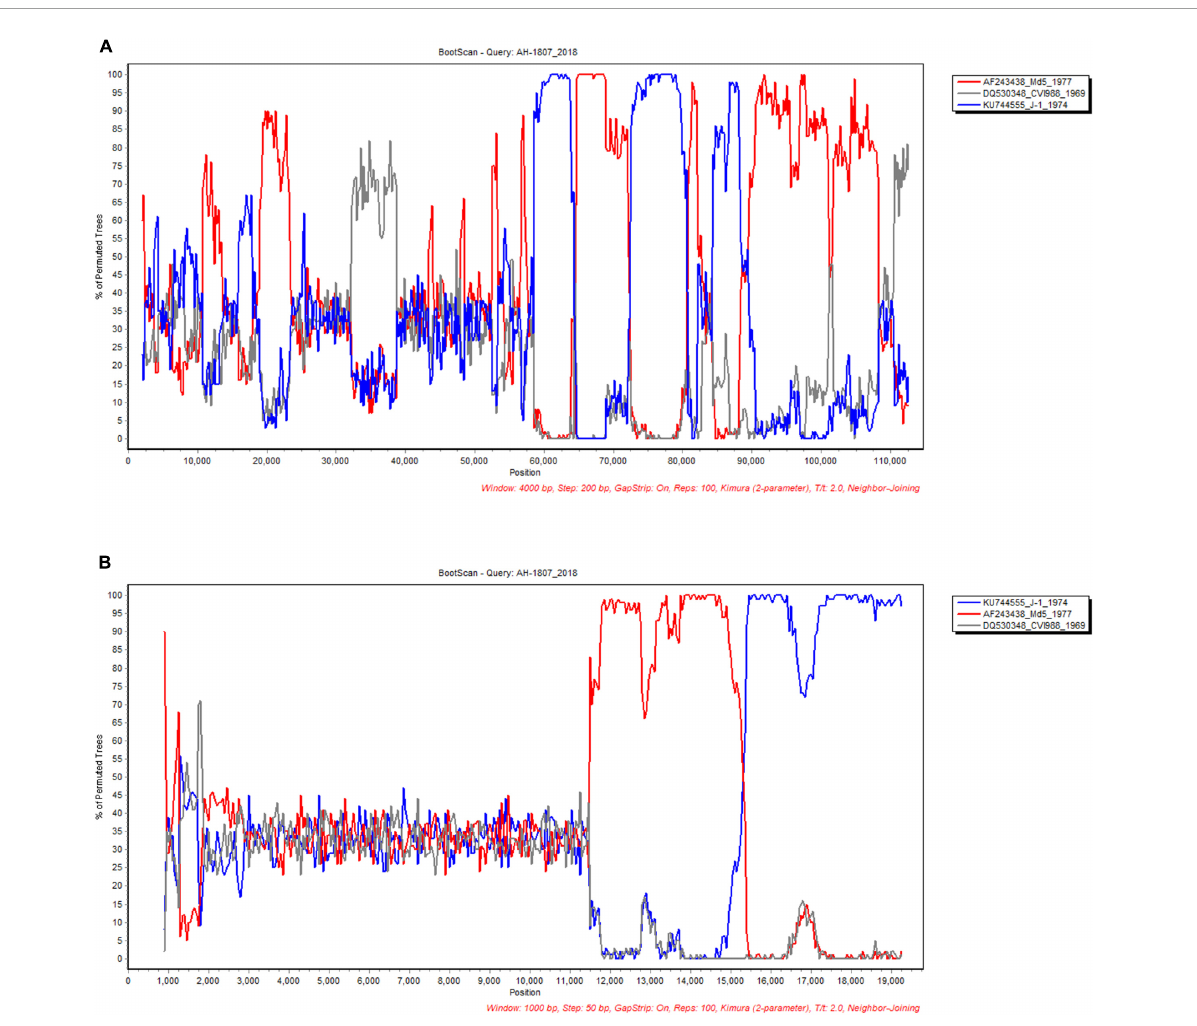
FIGURE6 Analyses of recombination crossover points in the unique long (UL) and unique short (US) sub-regions. The UL (A) and US (B) sub-region of AH/1807 strain were selected as query, and the corresponding sub-regions of the early Asian strain J-1, North American strain Md5, and vaccine strain CVI988 were chosen to perform bootscan analysis using